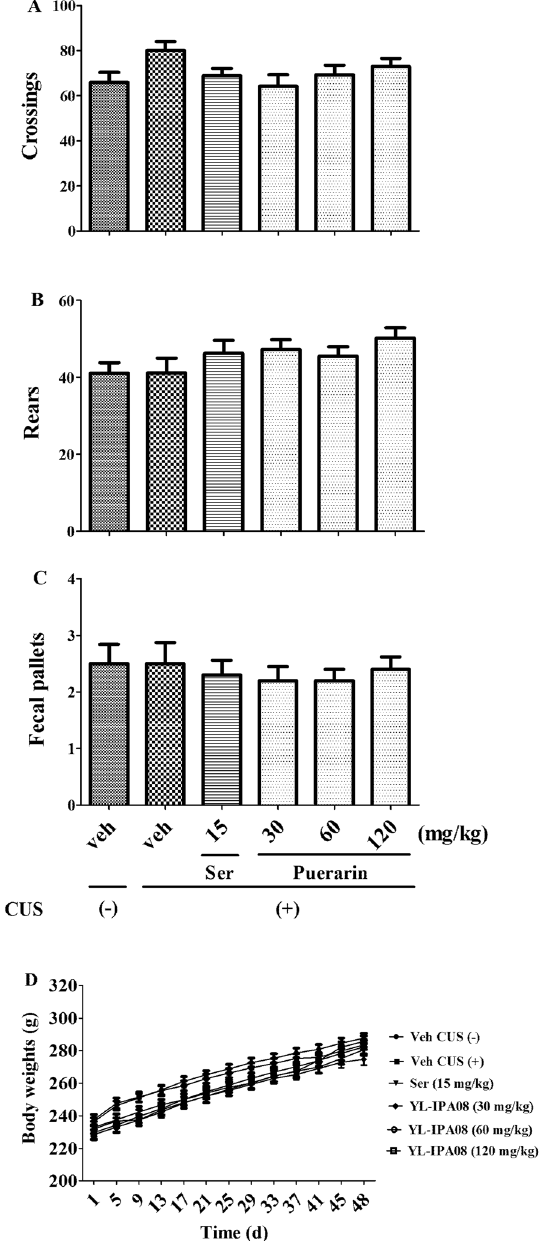
Figure 5. The effects of puerarin on locomotor activity. None of the treatments altered the number of line crossings ( A ), rears ( B ), and fecal pallets ( C ) in OFT. The body weights ( D ) were not altered by puerarin (n = 10 per